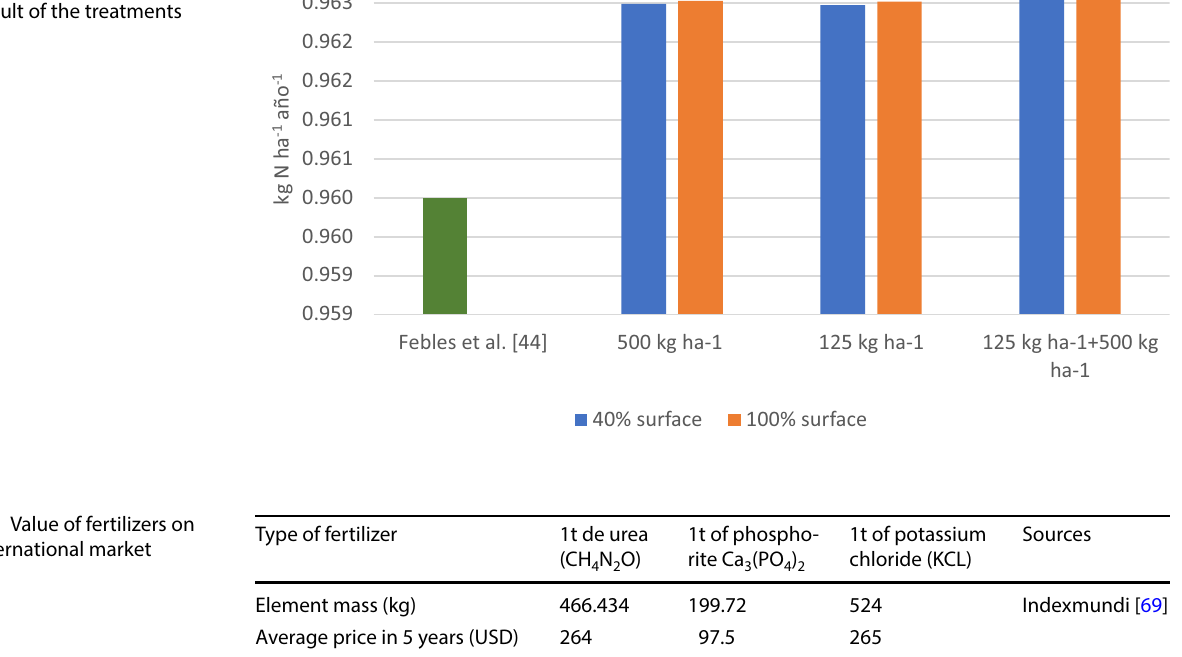
Fig. 16 Maximum nutrient export from the La Teresa basin as a result of the treatments